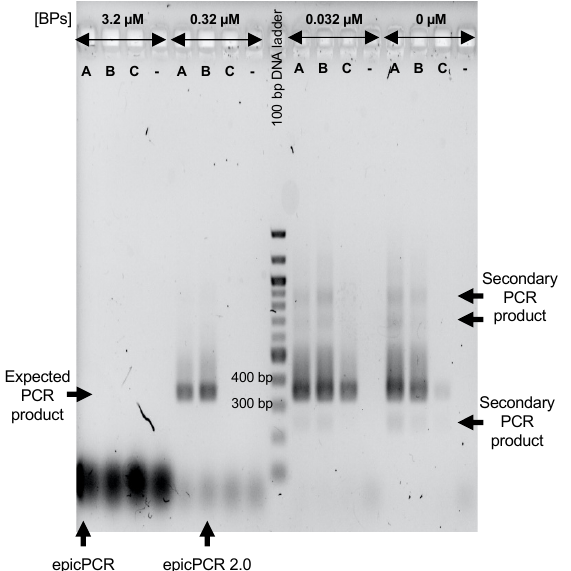
Figure 3. Efficiencies of two- and three-steps epicPCR protocols using different blocking primers (BPs) concentrations. The epicPCRs were run on SXT/R391 carrying bacteria from the Meurthe River water. A and C indicate wells with amplification products from two-steps epicPCR protocols (fu- sion-PCR on polyacrylamide beads + nested PCR). In the A lane, fusion-PCR products from the first step were used as template DNA in the second step without dilution whereas these products were diluted ten times in line C to circumvent the possible presence of PCR inhibitors. B indicates wells loaded with amplification products resulting from a three-steps epicPCR protocol (fusion PCR on polyacrylamide beads + blocking PCR with BPs as sole primers + nested PCR). The expected size of the final nested-PCR product is around 350 bp (depending on the 16S rRNA gene fragment poly- morphism). The conditions of epicPCR as used in Hultman et al. (2018) and that we determined to be the best in our conditions (epicPCR 2.0) are indicated by black arrows. The minus symbols indi- cate negative controls with epicPCRs run without polyacrylamide beads-template. In the original epicPCR setup [7,8], an OTU was validated when obtained in each of the three technical replicates carried out using a same batch of polyacrylamide beads. Such methodology, now on referred as a “3/3 technical replicates” OTU validation method, was initially proposed to address the possibility of more than one cell becoming embedded in the same bead with only one hosting the target sequence since it would be unlikely to happen twice. However, such validation parameters may appear (i) inappropriate when the target sequence is too rare as its presence in a sub-batch of beads will appear stochastic and (ii) not representative enough of the sample content. To go forward, we considered OTUs obtained from biological replicates, i.e., in epicPCRs performed using different beads batches. The use of biological replicates also makes unlikely the possibility to run twice an epicPCR on a same kind of undesired beads carrying the same two bacterial spe- cies. We therefore assumed that the detection of rare OTUs from biological replicates will be at least as robust as the one resulting from technical replicates. This alternative was evaluated by comparing outcomes obtained using the original “3/3 technical replicates” method, to those obtained using “3/3 biological replicates” and “2/3” or “2/2” biological or technical replicates (see Figure 4 for epicPCR replicate strategy). To do so, we deter- mined the significance of detecting a given OTU in all (“3/3” or “2/2”) or most (“2/3”) of the technical and/or biological replicates (Figures 5 and 6). Figure 5 depicts the influence of using a replicate strategy on the number and nature of OTUs that can be detected, while Figure 6 presents the global efficiency of each replicate strategy, i.e., the probability of detecting the maximal number of SXT/R391 hosts, expressed as the cumulative probabili- ties to detected the OTUs presented in Figure 5.